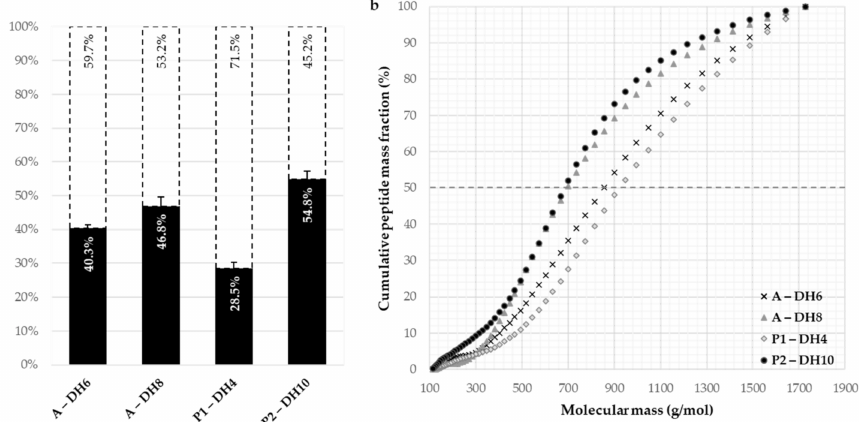
Figure 5. Protein conversion rates (dark blue histograms, %) and residual intact proteins (white histograms, %) of the chosen hydrolysates of the sunflower protein isolate ( a ) with Alcalase (A) and with Prolyve (P1 and P2) and the molecular weight distributions ( b ) determined by size exclusion chromatography. Chromatographic system: Superdex Peptide 10/300 GL column, detection at 214 nm, solvent: water/acetonitrile/TFA (69.9/30/0.1), flow rate of 0.5 mL · min − 1